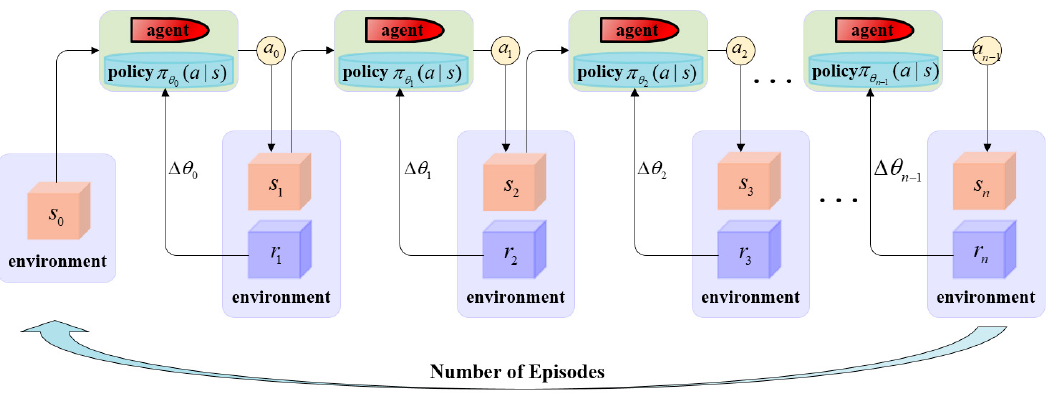
Figure 2. Schematic of the DRL method for ship-collision avoidance.